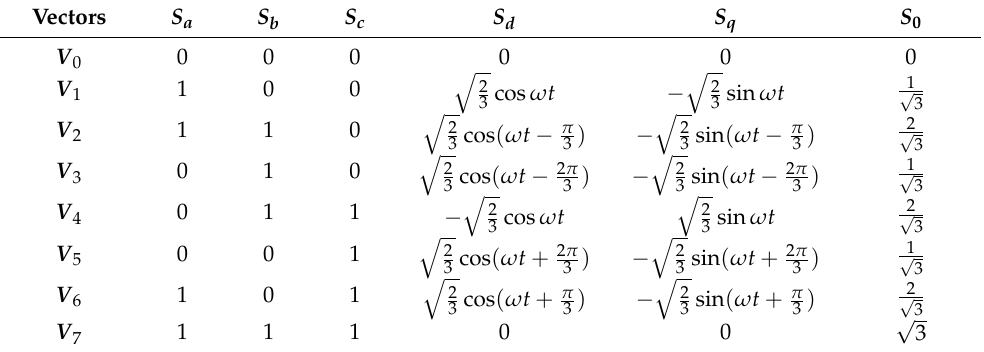
Table 1. The switching functions of basic voltage